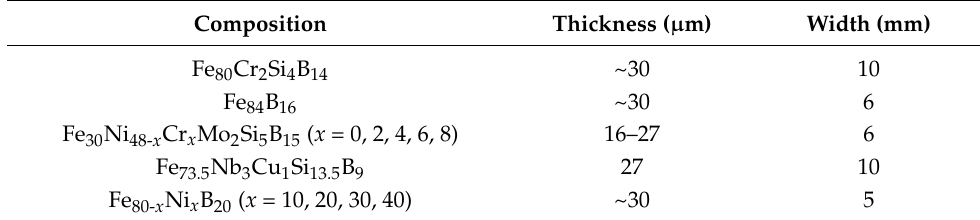
Table 1. Amorphous metallic alloys for neutron irradiation experiments.